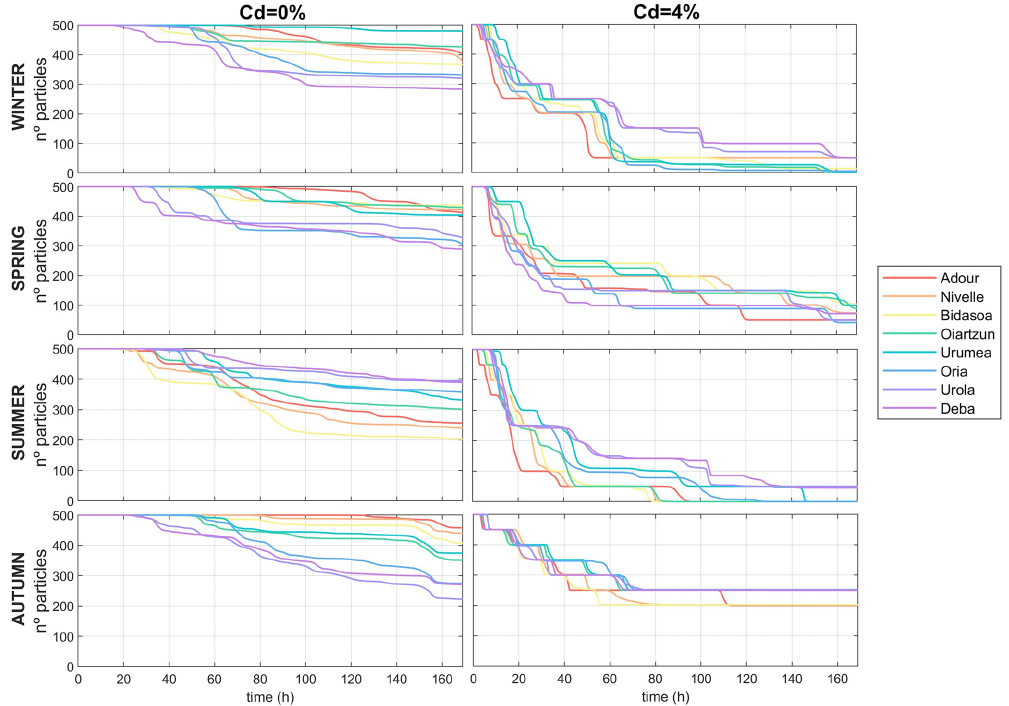
Figure 9. Temporal evolution of the particles parameterized with C d = 0% and C d = 4% throughout the different seasons. The curves represent the average number of particles floating in the water surface by river and for every time step.